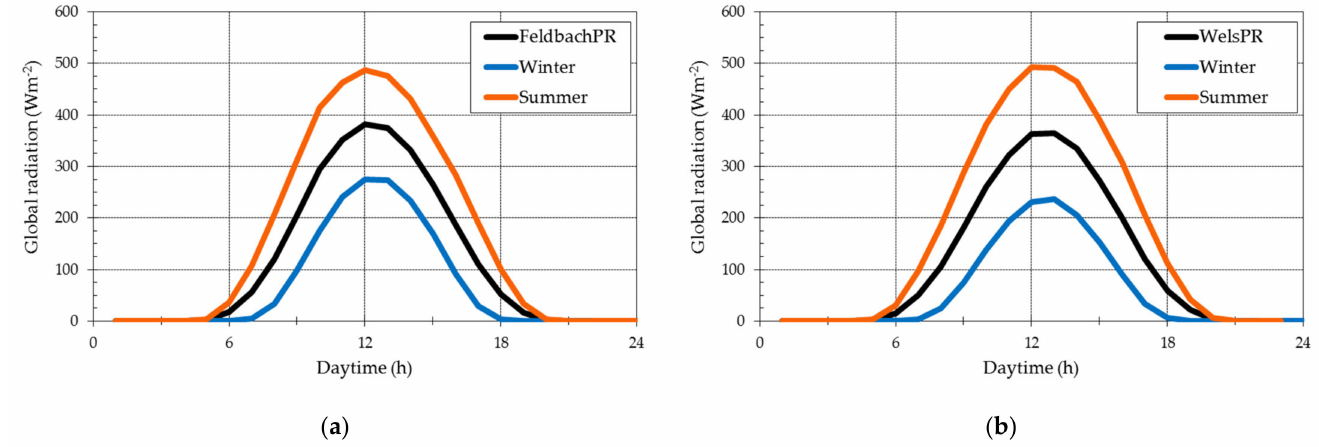
Figure 3. Winter, summer and annual means of the daily course of global radiation for ( a ) Feldbach and ( b ) Wels; PR— present (1981–2010).